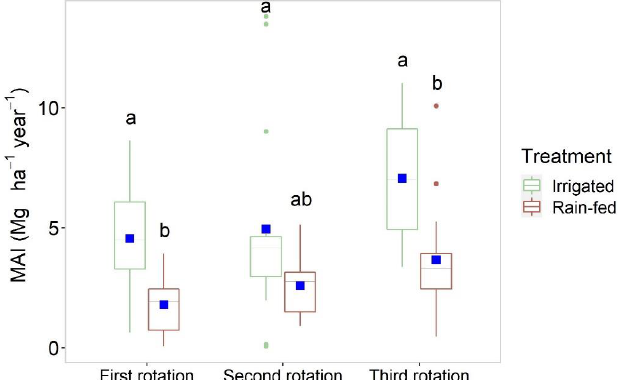
Figure 3. Mean annual increment (MAI) of Siberian elm above-ground biomass dry matter after first, second and third triennial rotation depending on treatment (boxes represent interquartile range; median is shown as center horizontal line in the box; whiskers show minimum and maximum observed values; mean values are represented by the blue squares; different letters represent significant ( P < 0.05) differences between all treatments and rotations).